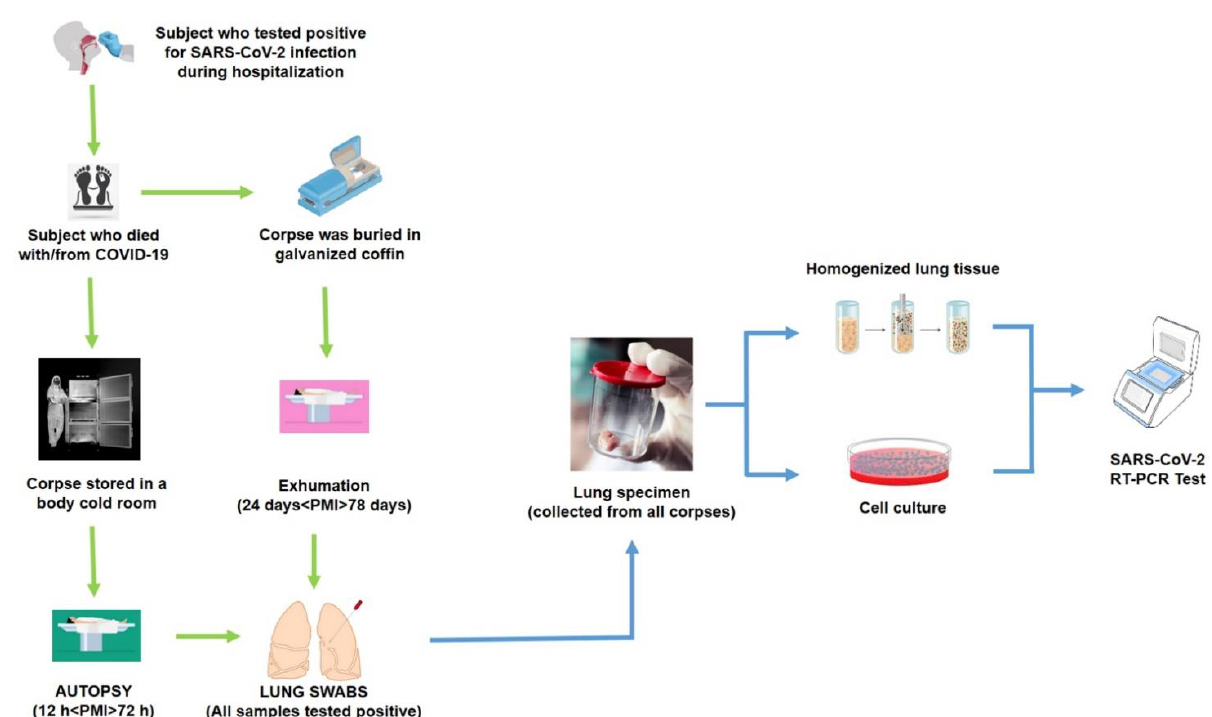
Figure 1. The protocol study: all samples were obtained by subjects died from/with COVID-19.